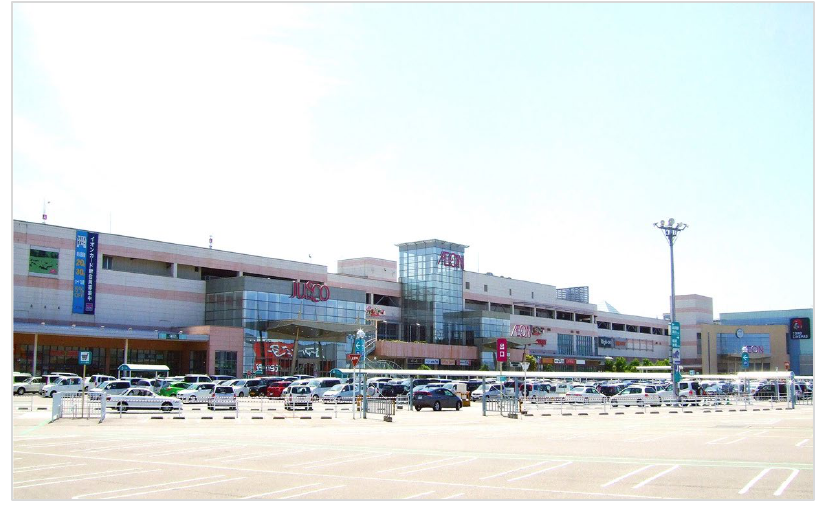
Figure 27 Shopping mall on a 205,000 square metre site in Takaoka